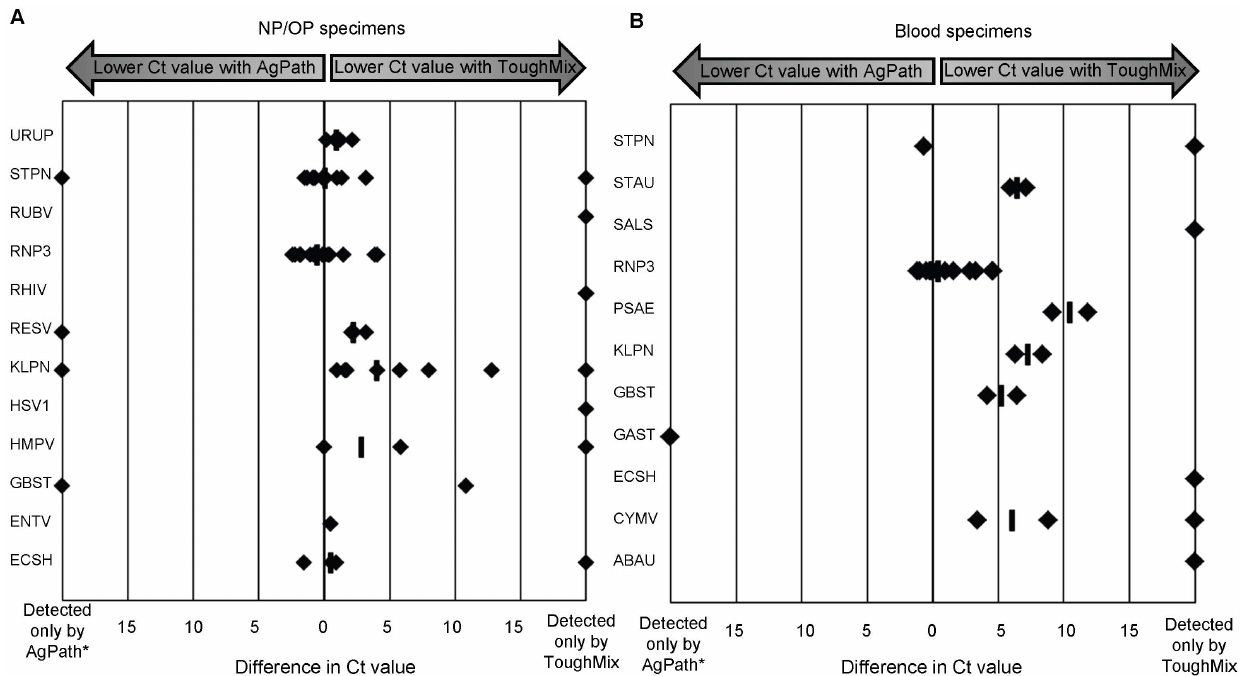
Figure 4. Effect of enzyme system on detection of pathogen targets in primary clinical specimens. Data shown are difference in Ct value between reactions using Quanta One-step RT-PCR ToughMix and AgPath-ID One-step RT-PCR kit when testing TNA extracted from NP/OP swabs (A) or blood (B). Each data point represents the difference in Ct value between the two reactions for an individual clinical specimen. Median difference is indicated ( _ ) for assays with $ 2 positive results. *Targets that were only detected using AgPath always occurred when Ct values were .